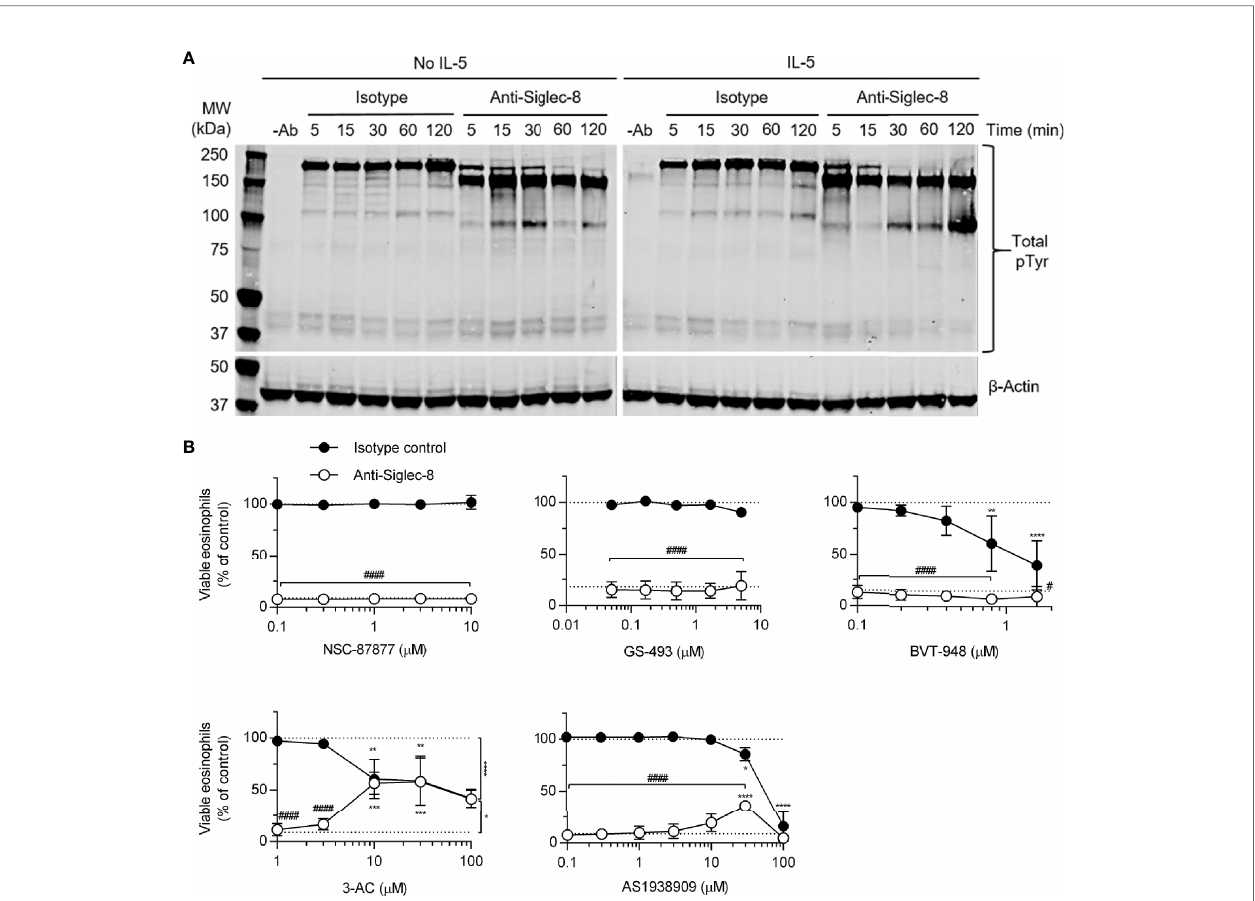
FIGURE 1 | SHIP1 activity is necessary for Siglec-8 – induced eosinophil cell death. (A) Eosinophils were treated with anti-Siglec-8 (clone 2C4) or isotype control mAb (IgG1) for the indicated durations in the absence of IL-5 (No IL-5) or after being primed in the presence of 30 ng/ml IL-5 for 18 – 24 hr. The cells were then lysed, and the lysates separated by SDS-PAGE and transferred to a PVDF membrane. Tyrosine-phosphorylated proteins were detected using a phosphotyrosine-speci fi c antibody. Blots are representative of three independent experiments. (B) IL-5 – primed eosinophils were pretreated with pharmacological inhibitors of SHP-1/2 (NSC- 87877, GS-493, BVT-948), SHIP1 (3-AC), or SHIP2 and SHIP1 (AS1938909) at the indicated concentrations for 30 min prior to treatment with anti-Siglec-8 (open circles) or isotype control mAb ( fi lled circles) for 18 – 24 hr. Cell viability was then assessed by annexin V and DAPI staining by fl ow cytometry and normalized to the cell viability measured in untreated samples. Dotted lines indicate viability levels with no pharmacological inhibition. Data represent means ± standard deviations of 3 independent experiments. *p < 0.05, **p < 0.01, ***p < 0.001, ****p < 0.0001 relative to within – antibody stimulation group vehicle control sample. # p < 0.05, #### p < 0.0001 relative to isotype control sample at the same pharmacological inhibitor